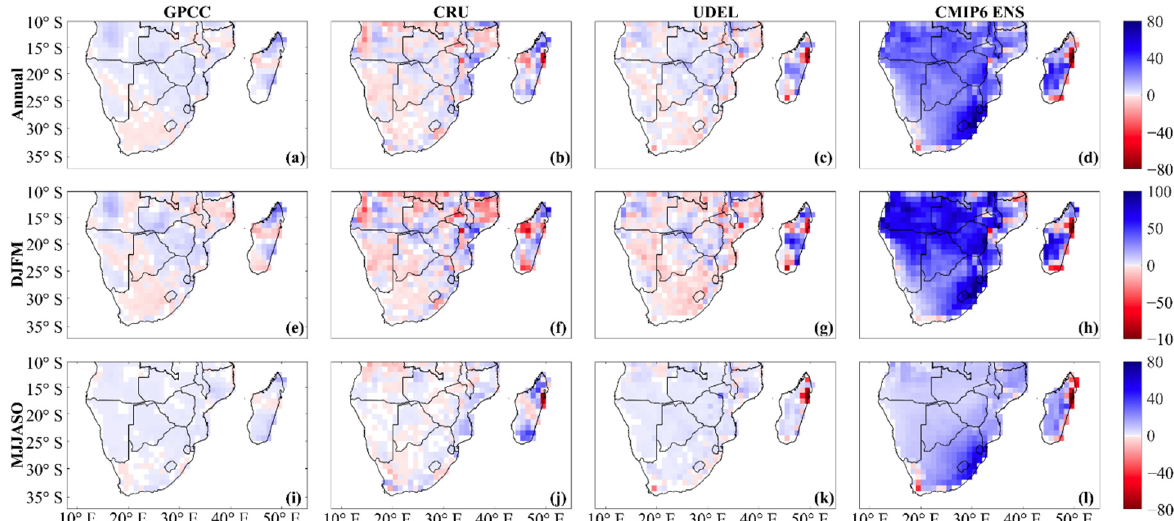
Figure 3. Southern Africa seasonal precipitation anomaly (mm) from 1901–2014. ( a – d ) Annual; ( e – h ) DJFM; and ( i – l ) MJJASO precipitation. ( a , e , i ) GPCC; ( b , f , j ) CRU; ( c , g , k ) UDEL; and ( d , h , l ) CMIP6 ensemble. The seasonal anomaly is calculated relative to the baseline period. The spatial distributions of the individual GCMs are presented in Figures A2 and A3 for DJFM and MJJASO, respectively.